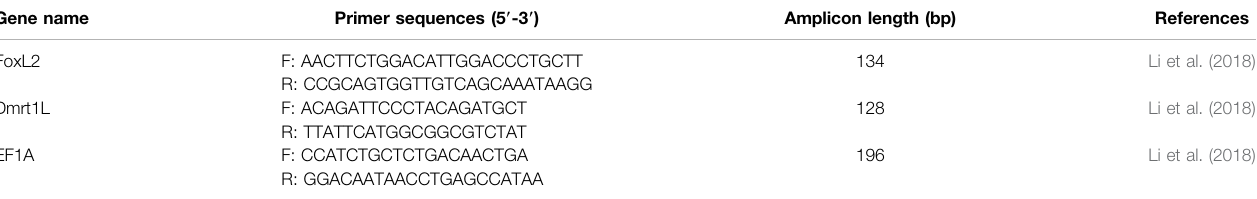
TABLE 1 | Sequences of the primers used for RT-qPCR assay.